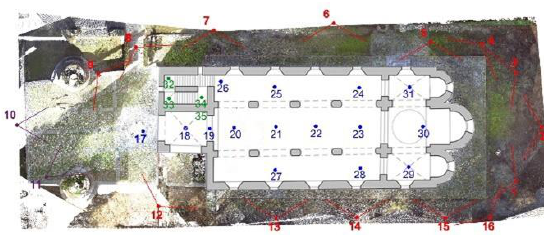
Figure 2 . Laser scanner data acquisition: external (a) and internal survey (b).